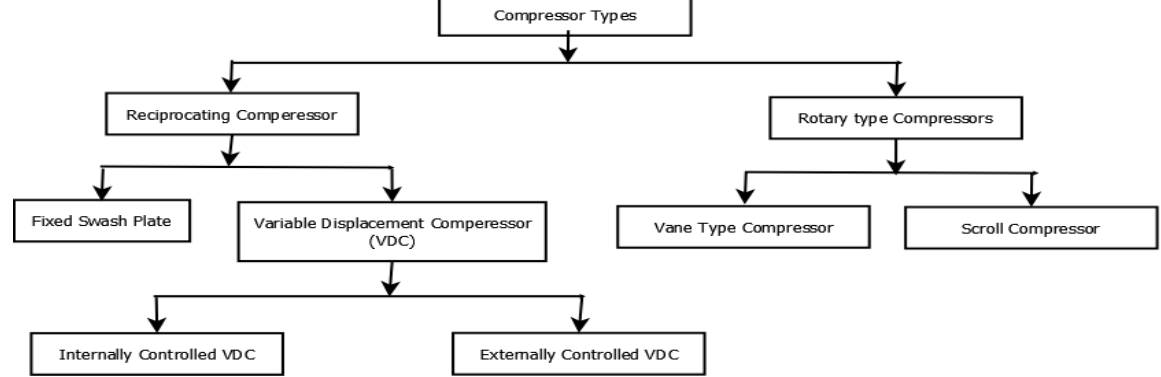
Figure 7. Air conditioner compressor classification and types.